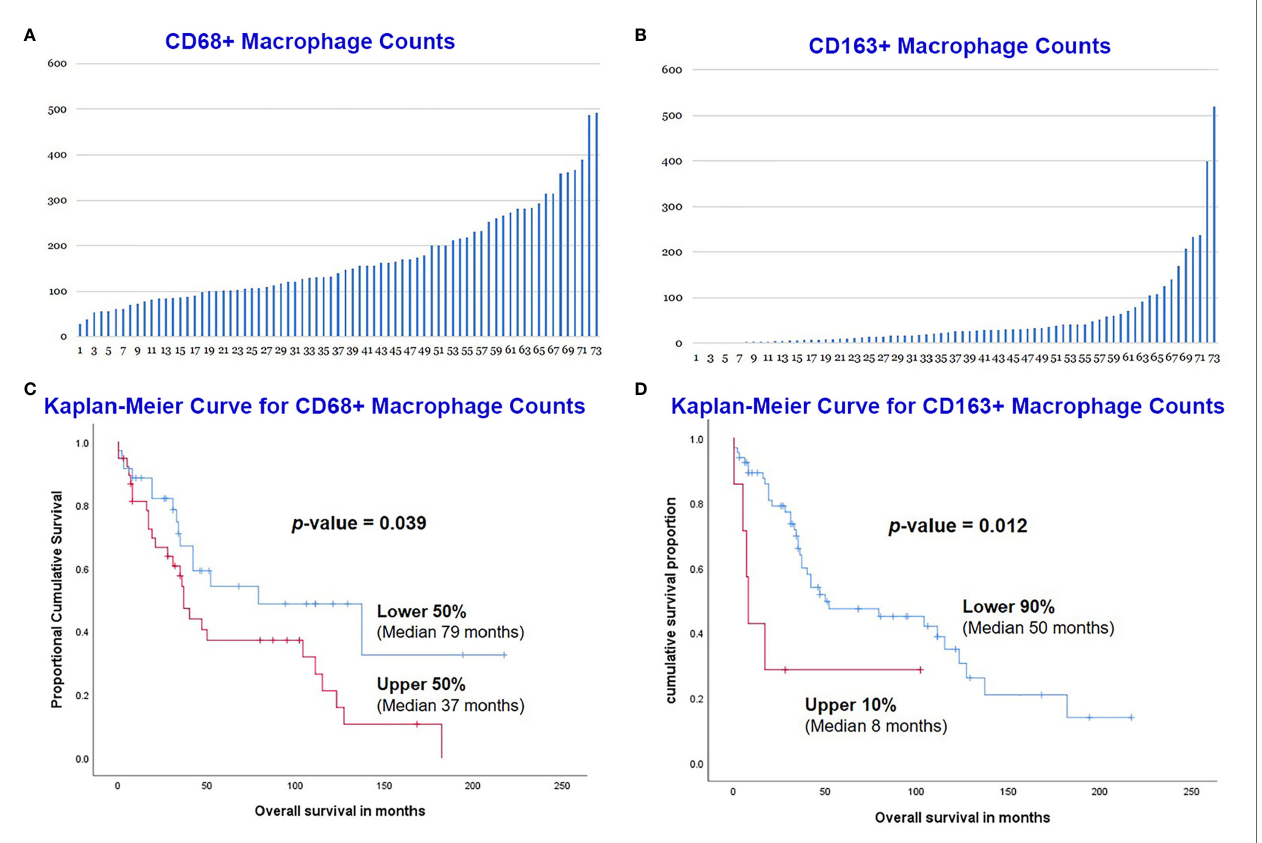
FIGURE 2 | Manual count of CD68+ macrophages (A) and CD163+ macrophages (B) in the 73 MCL cases. MCL with lower CD68+ counts had a better overall survival (OS) than those with higher counts (C) . The lower count of CD163+ macrophage also predicted an improved OS (D)